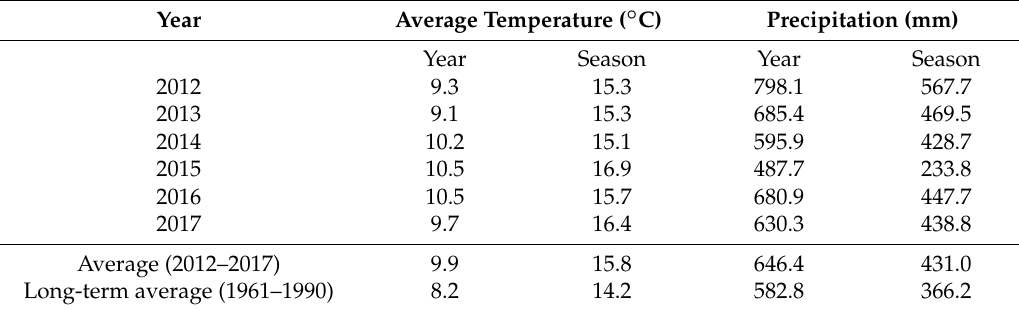
Table 1. Temperature and precipitation characteristics— ˇCesk é Budˇejovice (modified from